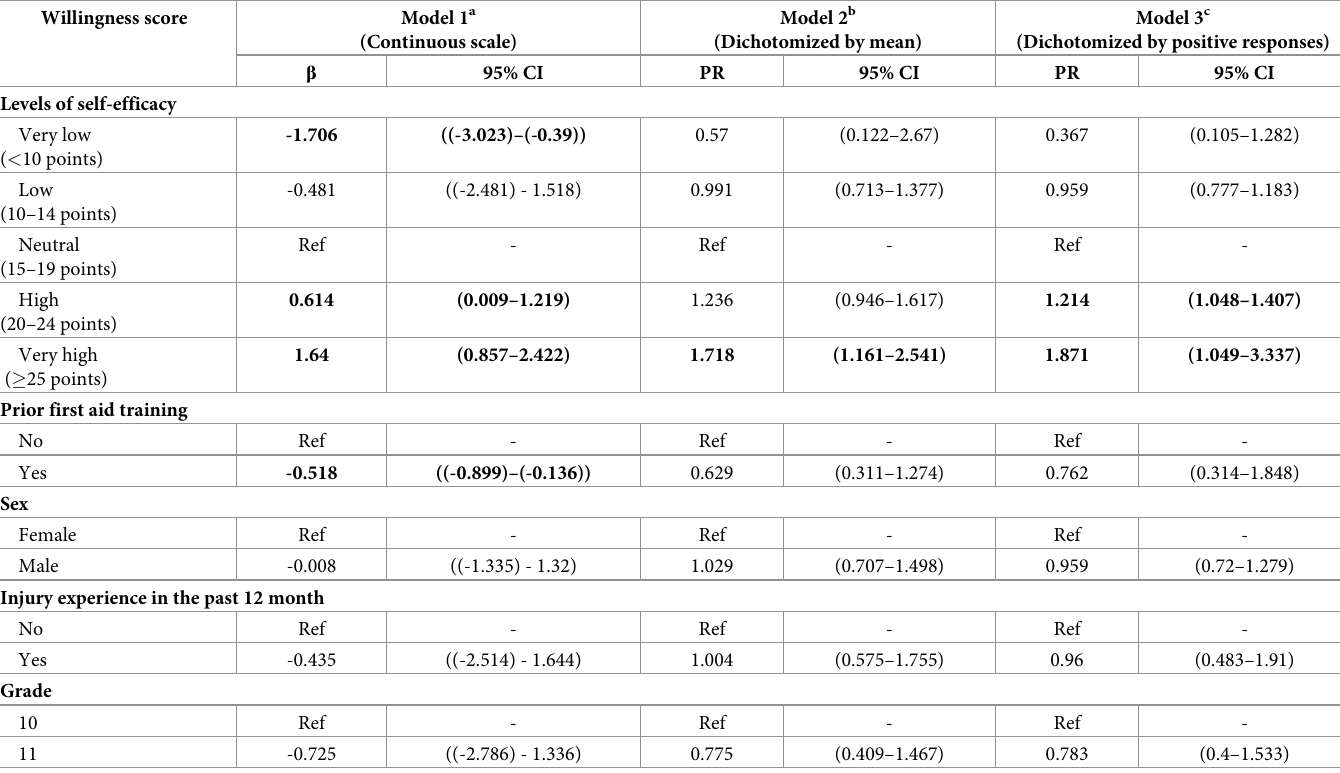
Table 4. The multivariable model of students’ willingness to perform first